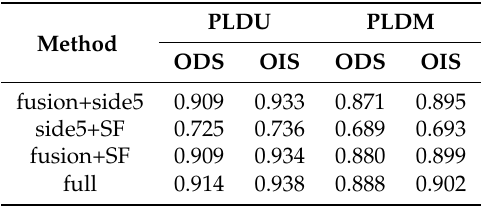
Table 5. Experiments on two datasets for ablation